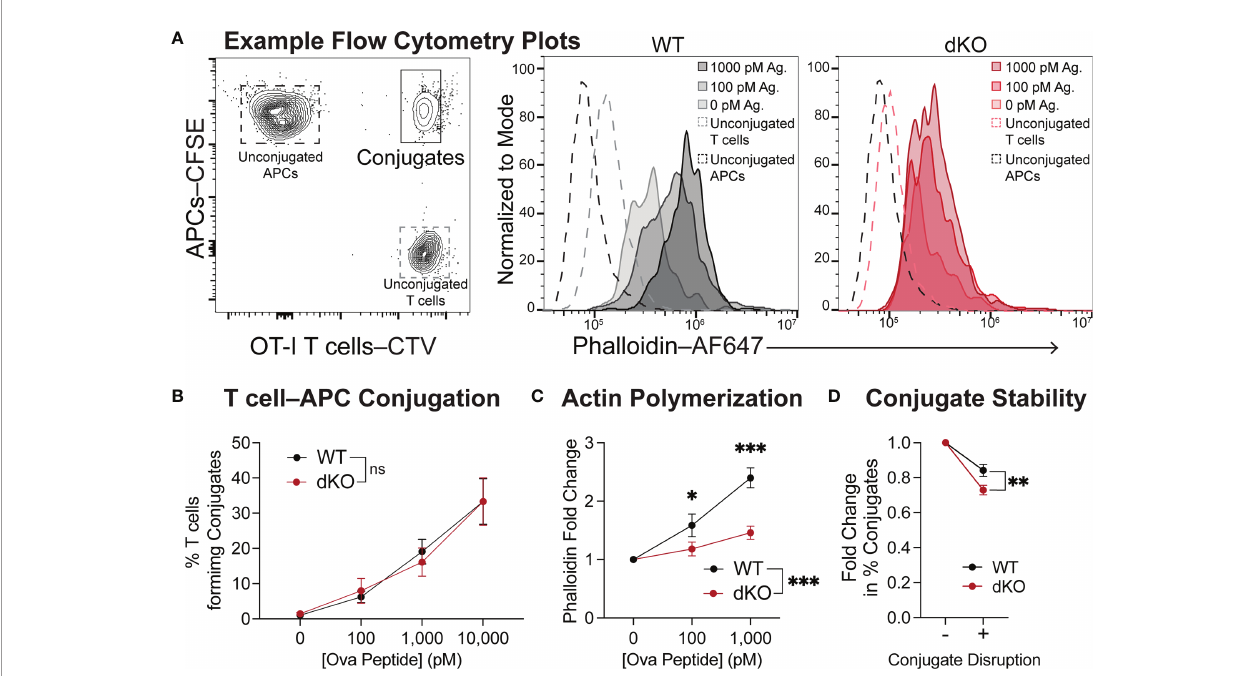
FIGURE 5 | EVL/VASP-de fi cient T cells have impaired actin polymerization during conjugation with APCs and form fewer stable conjugates. Naïve WT and EVL/VASP dKO OT-I T cells were dye-labeled with CTV and mixed with CFSE-labeled WT splenocytes pulsed with SIINFEKL peptide. T cells and APCs were centrifuged together, cocultured for 2 minutes, and stained for F-actin with phalloidin. (A) Left; gating used to identify T cell – APC conjugates. Right; example histograms of phalloidin staining in the conjugates formed by WT and EVL/VASP dKO T cells. (B) Quanti fi cation of the % of naïve WT and EVL/VASP dKO OT-I T cells that formed conjugates with APCs. No signi fi cant difference (ns) determined by 2-way ANOVA. (C) F-actin polymerization in T cell – APC conjugates. Graph depicts the fold change in phalloidin (GMFI) in WT and EVL/VASP dKO T cell conjugates compared to conjugates that formed in the absence of antigen (0 pM). Data are from 3 experiments each with ≥ 2 replicates per group. Signi fi cance was assessed by 2-way ANOVA; * is p < 0.05, *** is p < 0.001. (D) T cell conjugate stability was quanti fi ed by comparing T cell – APC conjugates (using 1000 pM OVA peptide) fi xed immediately after 2-minute incubation (- Conjugate Disruption) or disturbed by brie fl y vortexing tubes before fi xation (+ Conjugate Disruption). Graph depicts fold change in % of conjugates from the undisrupted control. Data are from 3 experiments with 3 replicates per group. Signi fi cance was assessed by paired t test; ** is p <